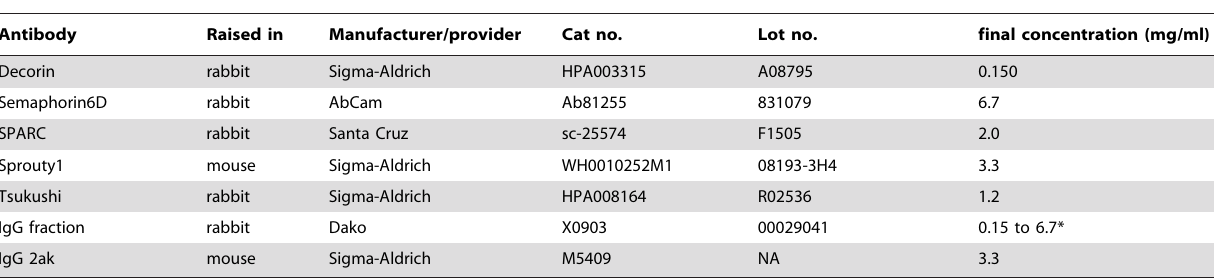
Table 3. Antibodies for Immunohistochemistry.